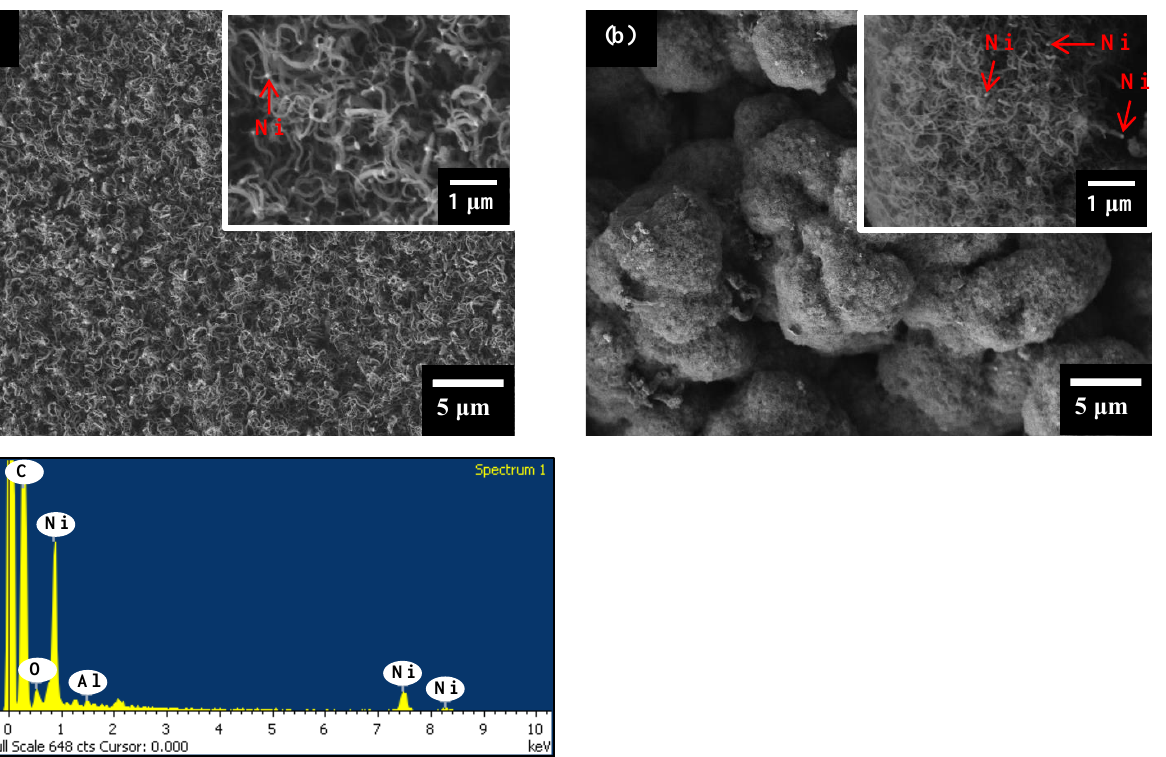
Figure 11. SEM surface morphologies of the catalysts after ESR reactions for 5 h: ( a ) NaOH_T + R catalyst; ( b ) NaHCO 3 _T + R catalyst; ( c) EDS spectrum presented as the high Ni contents were detected at bright particles on the tips of filamentous carbons in the SEM images ( a , b ).